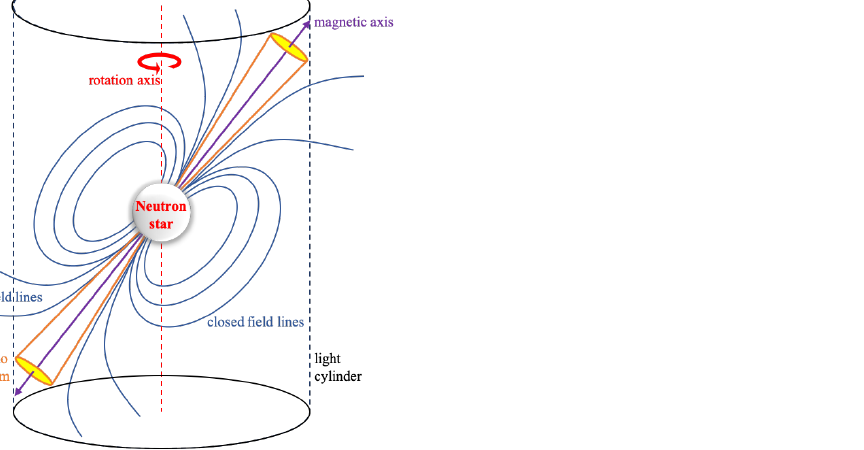
Figure 1. The conventional magnetic dipole model: a schematic view of the key features of a pulsar magnetosphere